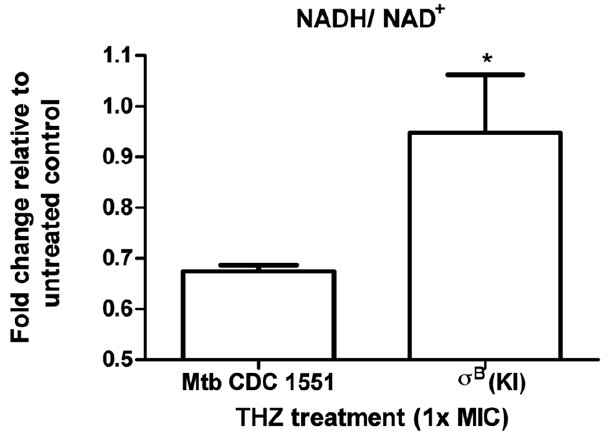
Figure 4. Changes in redox status of NADH/NAD + during treatment of Mtb CDC 1551 and s B (KI) mutant with THZ. The results represent mean 6 SD values from three experiments. s B over expression induced by the addition of acetamide to 0.2%.